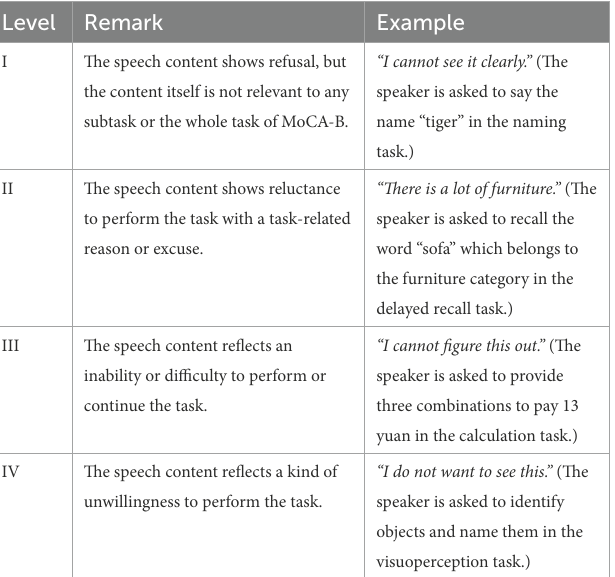
TABLE 1 Four levels of the